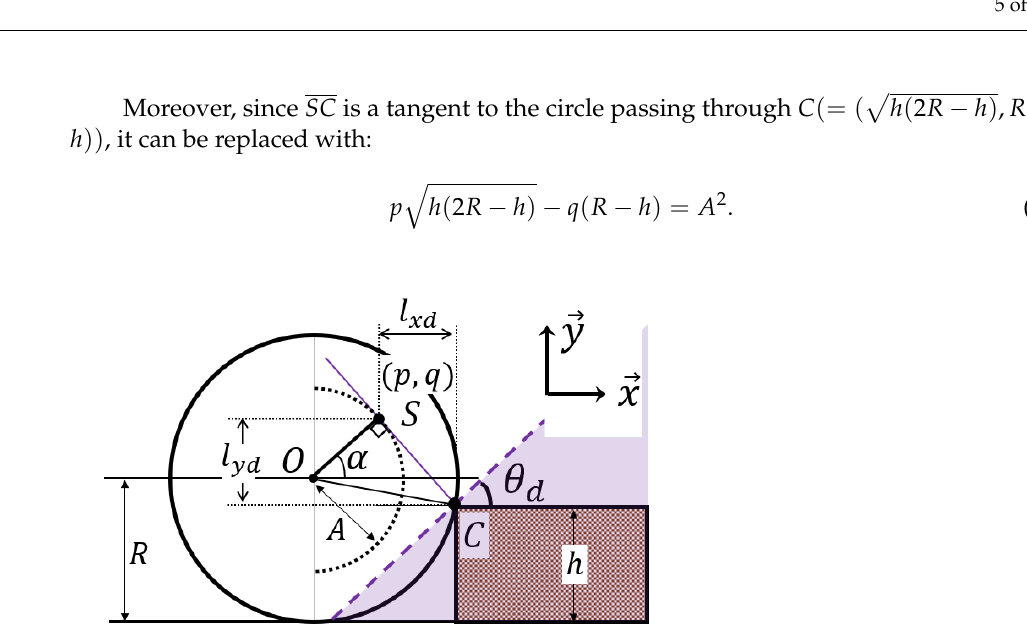
Figure 4. Illustration of angle α derived from θ d to determine another